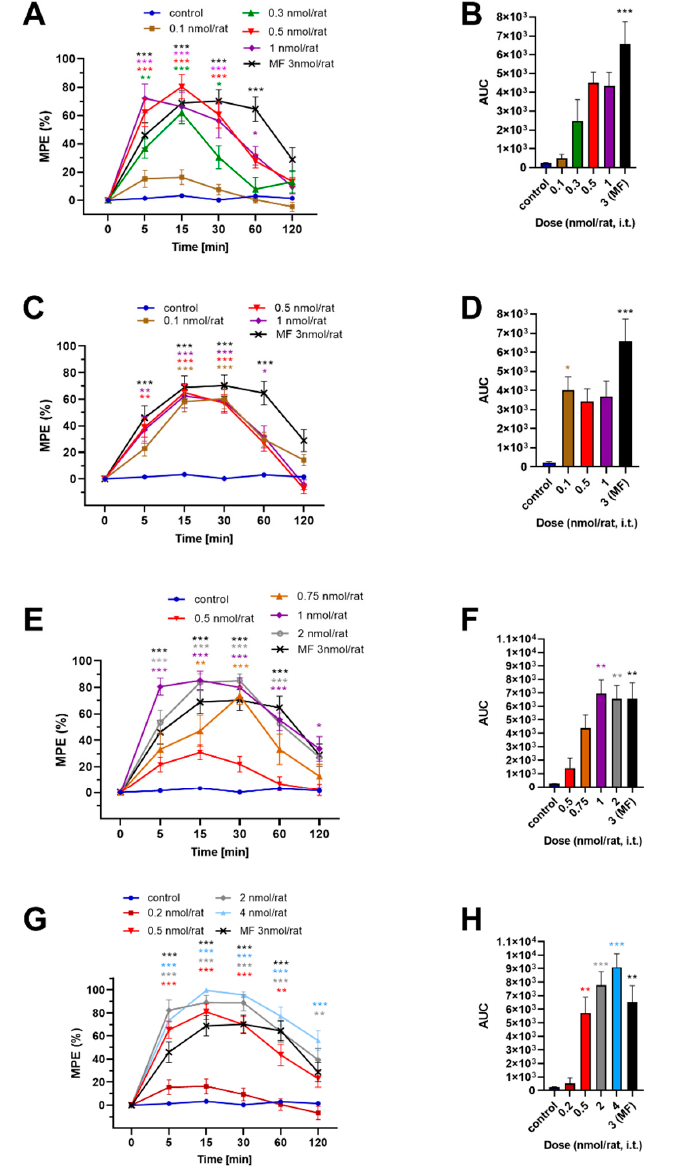
Figure 7. Analgesic responses of compounds 1a ( A , B ), 1b ( C , D ), 1c ( E , F ), and 1d ( G , H ), as well as morphine (MF). In the left column given is the time course curve of the effect. In the right column are column plots of the area under the time course curve (AUC) for different doses. Results were either analyzed with two-way ANOVA followed by the Bonferroni post-hoc test ( A , C , E , G ) or one-way ANOVA followed by the Dunnett post-hoc test ( B , D , F , H ) and plotted as the mean ± SEM ( n = 4–8). Asterisks (*) indicate a significant difference compared with saline-injected animals. Note: * p < 0.033, ** p < 0.002, and *** p < 0.001.